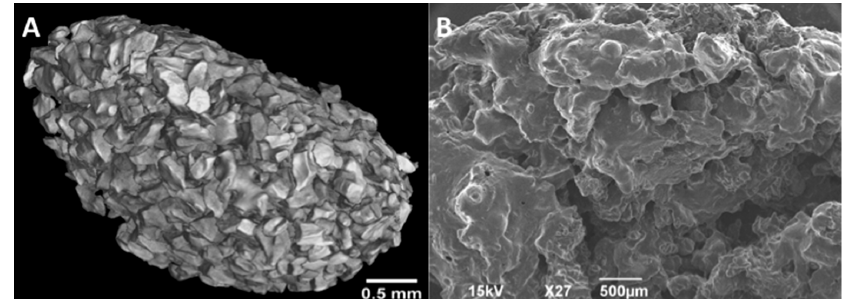
Figure 4. The homogeneity of the composition, percent of Bone Void Filler (BVF), and the porosity of the BVF putty was determined for a model formulation of a Polycaprolactone/poly ethylene glycol/ poly(lactic-co-glycolic acid) (PCL/PEG/PLGA) putty using micro computer tomography (CT) on a small cylindrical disk ( A ); and SEM through the center of a large sphere ( B ).